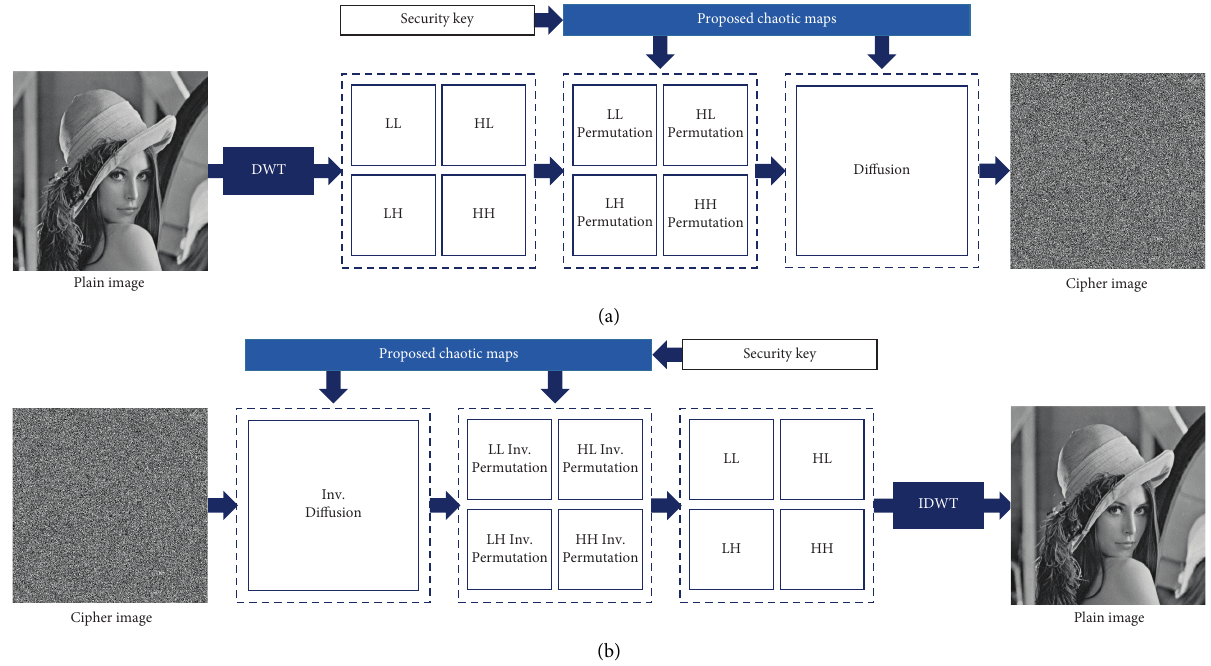
Figure 11: Schematic illustration: (a) the encryption processes, and (b) the decryption processes. Note that DWT, LL, LH, HL, HH Inv. Diffusion, Inv. Permutation, and IDWTstand for, Discrete Wavelet Transform, low-low, low-high, high-low, high-high, inverse diffusion, inverse permutation, and inverse Discrete Wavelet Transform,